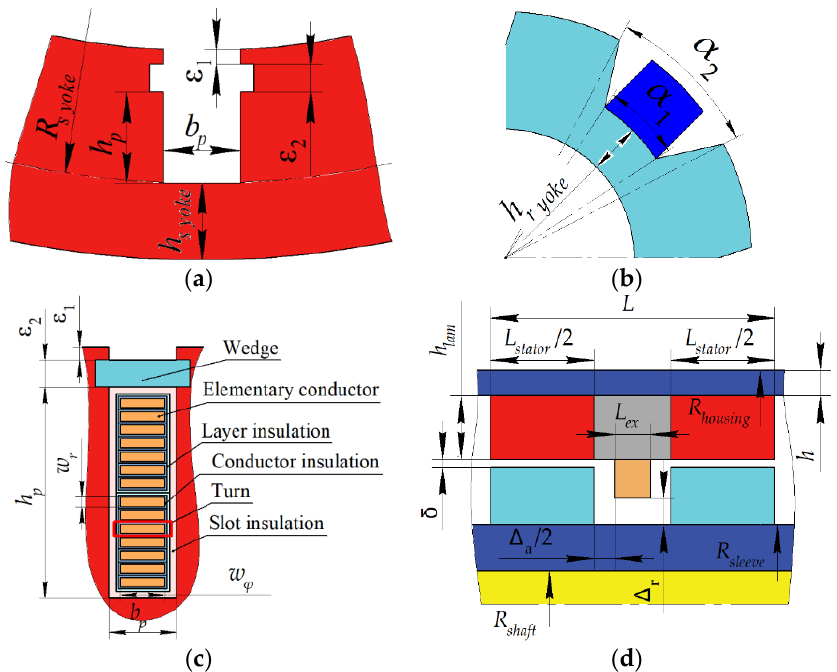
Figure 6. Parameters of the SHG geometry. ( a ) Stator core parameters; ( b ) Rotor core parameters; ( c ) Armature winding parameters; ( d ) Parameters in the axial plane.